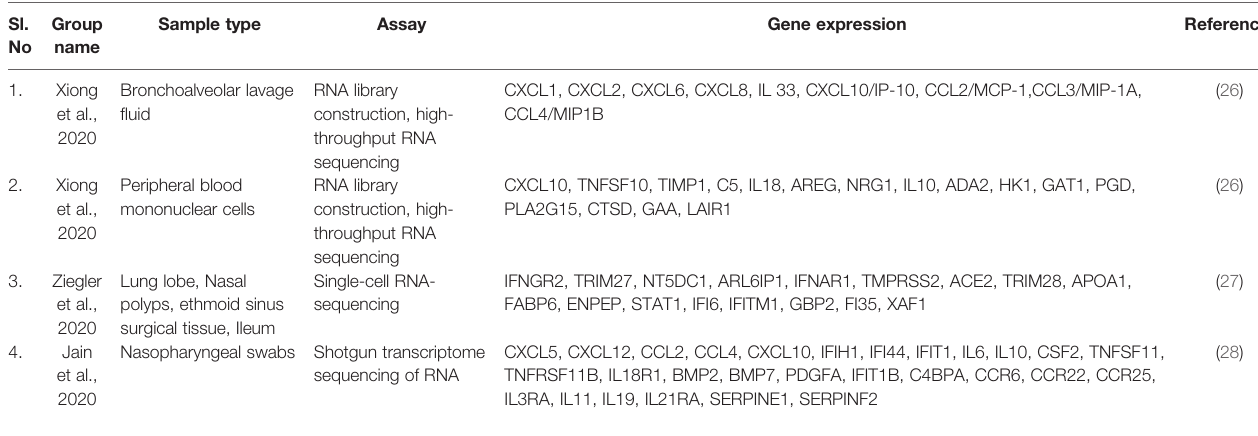
TABLE 2 | List of top ranking expressed genes of COVID-19 patients from the different